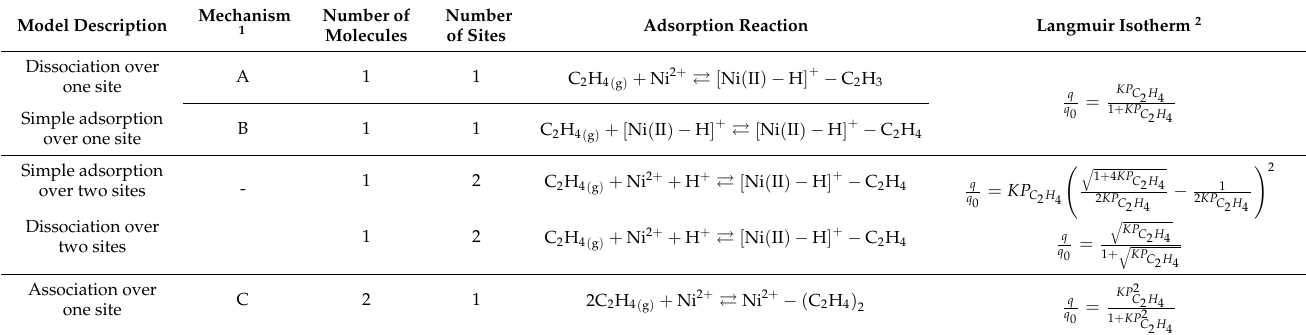
Table 1. Langmuir isotherms developed based on the mechanisms depicted in Figure